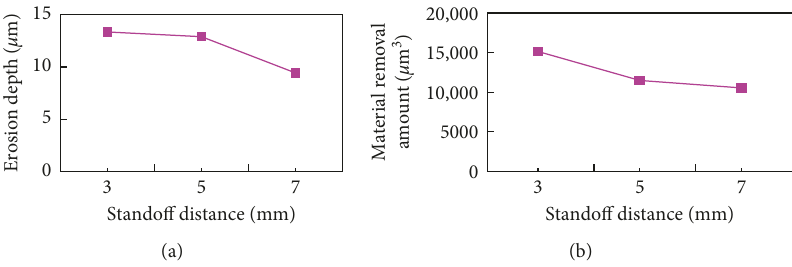
Figure 10: The influence of the standoff distance on (a) erosion depth and (b) material removal amount.